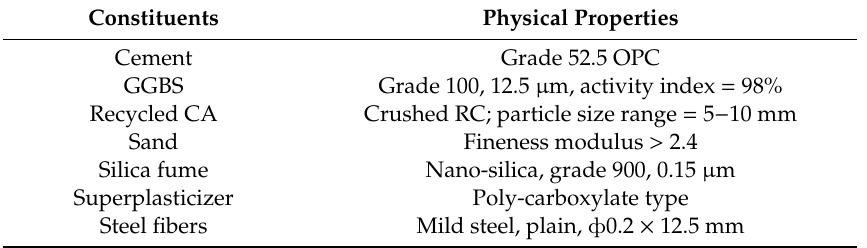
Figure 4. Details of deck type C (units in mm). Table 2. Constituent material properties for sustainable ultra-high performance concrete (sUHPC).